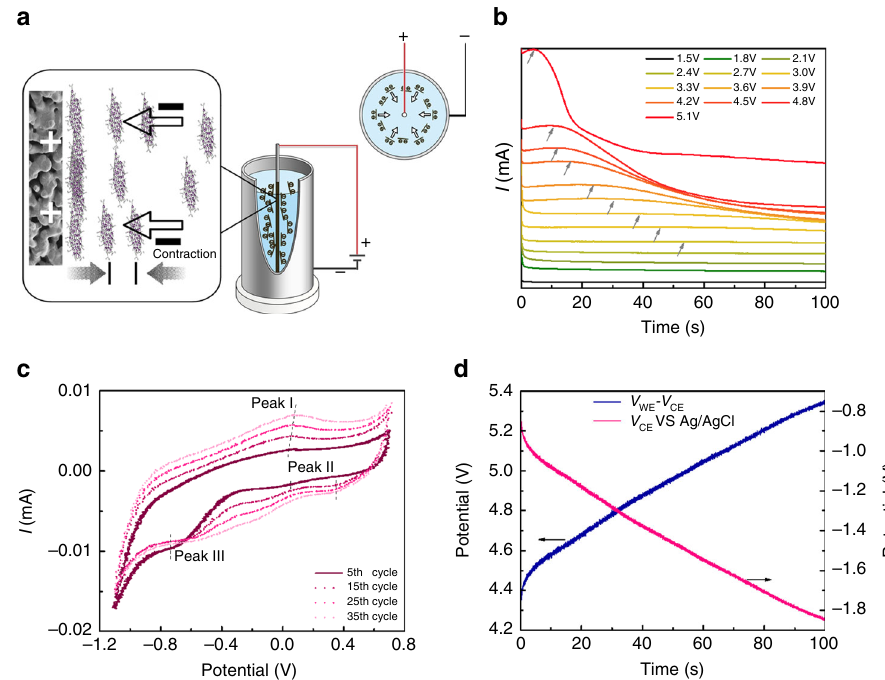
Fig. 1 Electrophoresis deposition of graphene oxide on PSSHF. a Schematic of GO electrophoresis deposition on PSSHF with a circular electric fi eld, b current variation with fi xed DC voltages of V WE – V CE in the GO electrophoresis deposition, c CV curves of GO on the glass-carbon electrode at room temperature and d time dependence of voltages V WE – V CE and V CE in the three-electrode system for GO deposition with a V WE of 3.2